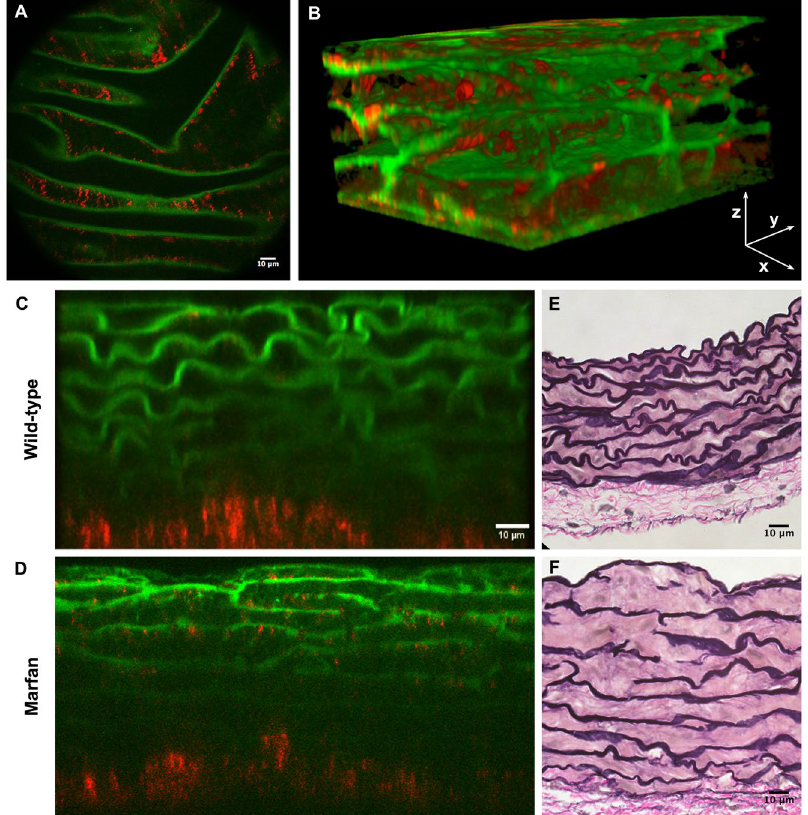
Figure 1. Aortic tissue visualizations using multiphoton microscopy. ( A ) En-face perspective of the IEL of the ascending aorta from a WT mouse using multiphoton microscopy. TPEF signal of elastin in green and SHG signal of collagen in red. ( B ) Three-dimensional rendering of a portion of the tunica media from the ascending aorta of a WT mouse. ( C and D ) Representative multiphoton images of the tunica media in transverse views of WT ( C ) and Marfan ( D ) mice. ( E and F ) Conventional histological visualization of elastic fibres using Verhoeff- van Gieson staining in WT ( E ) and Marfan ( F ) aortic tissue. Scale bar, 10 μ